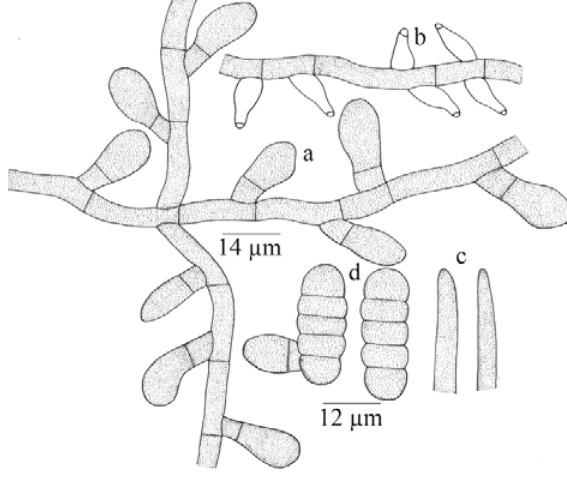
Figure 126. Meliola wendlandiae a - Appressorium; b - Phialide; c - Apical portion of mycelial setae; d -